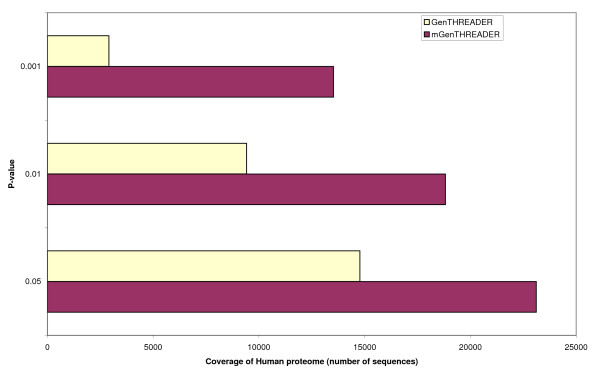
Estimated coverage of Human proteome. Coverage of sequences with assigned structures at standard p-value cut-offs (< 0.001, < 0.01 and < 0.05). The sequence-profile method GenTHREADER is compared to the more rigorous profile-profile version of mGenTHREADER. See methods section for explanation of p-values.